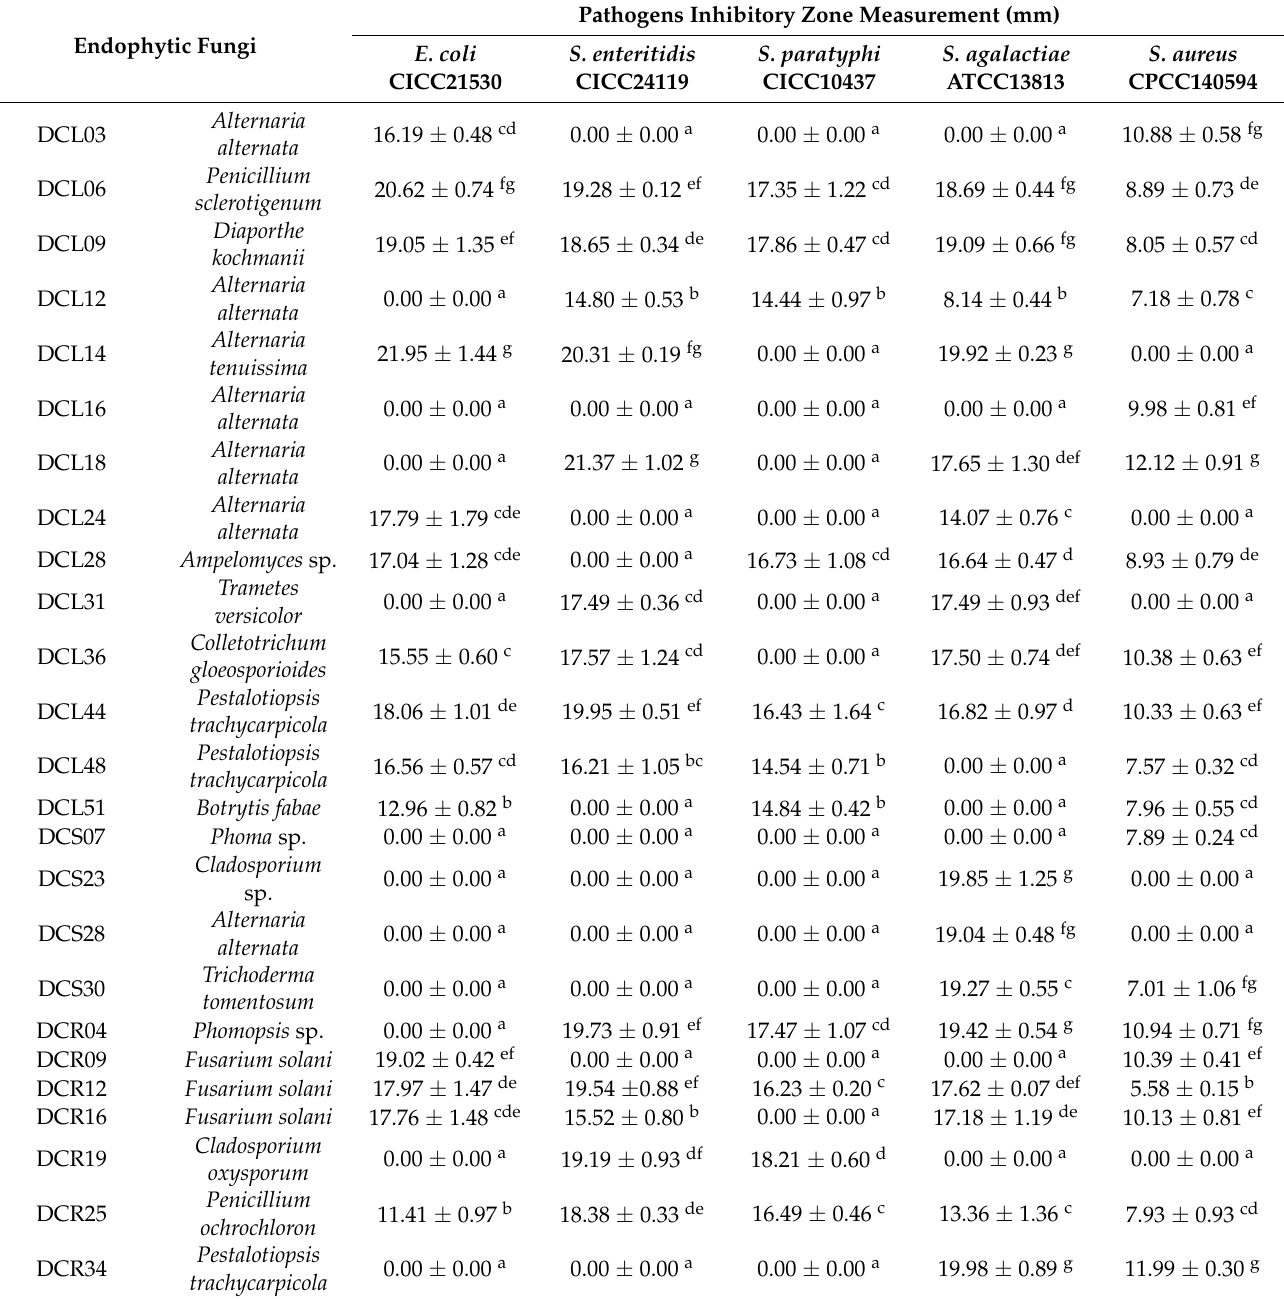
Table 3. Antibacterial activity of endophytic fungi isolated from A. adenophora